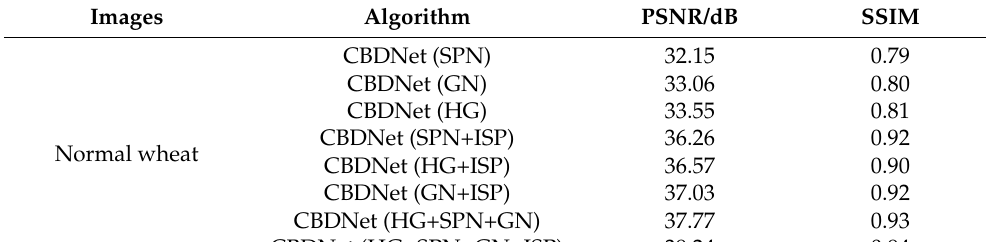
Table 2. The PSNR/SSIM results for different noise models.